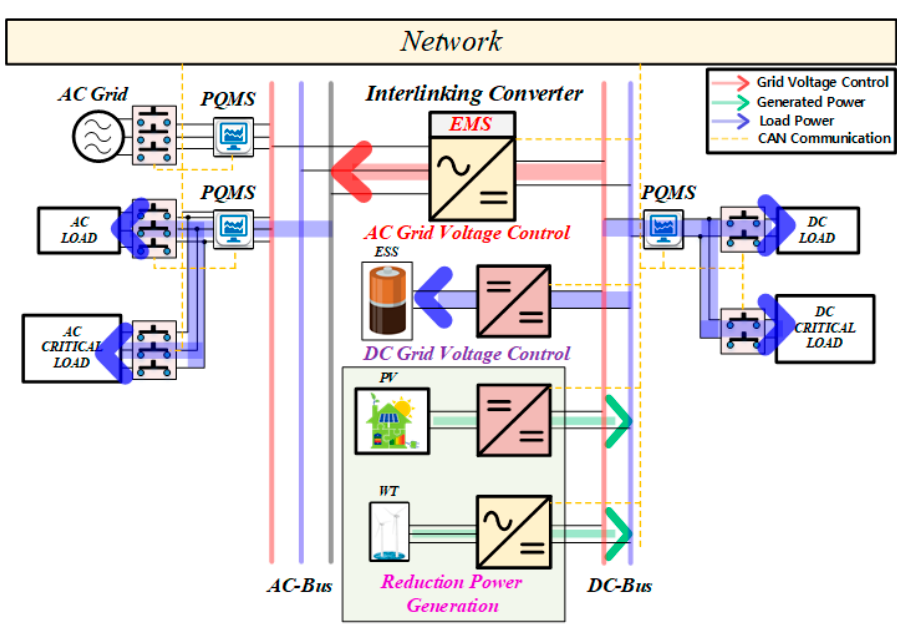
Figure 11. Power flow diagram of the RP mode (mode 5).